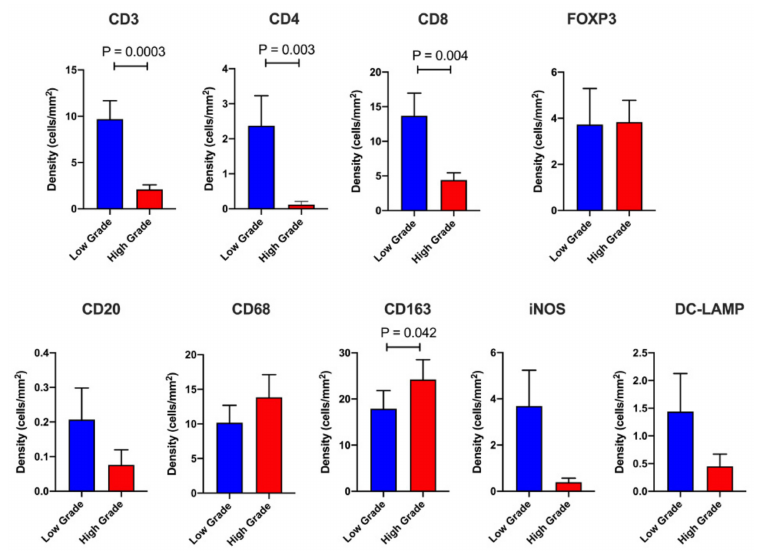
Figure 2. Intratumoral (IT) immune profiling. Barplots displaying the IT leukocyte density in High Grade ( n = 54) versus Low Grade ( n = 57) tumor budding cases. The following immune cell markers were utilized (CD3, CD4, CD8, FOXP3, CD20, CD68, iNOS, CD163, DC-LAMP). Data are depicted as mean + standard error (SE). Differences between groups were analyzed using the Mann-Whitney U test. Only significant p -values (<0.05) are shown on the graph.